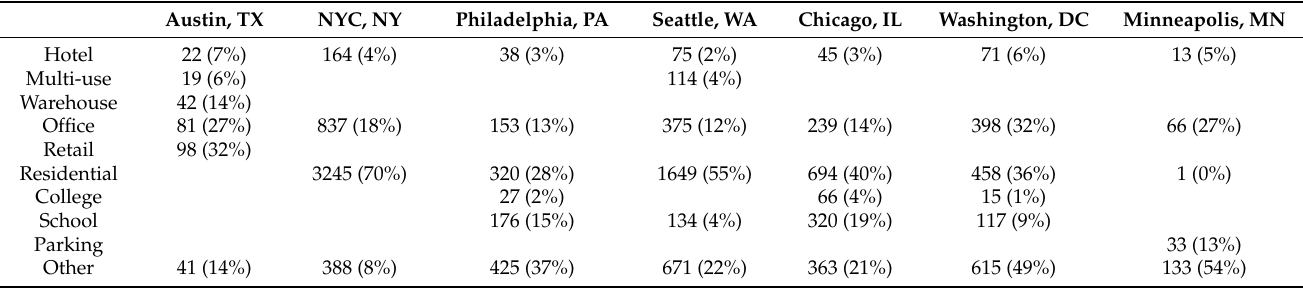
Table 1. Summary of building-type shares in different cities’ datasets.